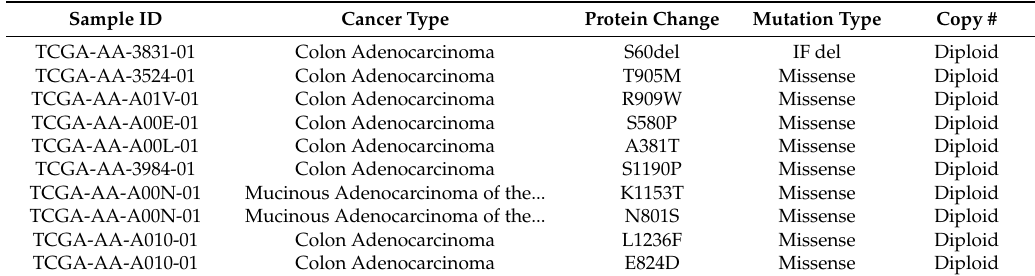
Figure 3. Modulation of the transcriptional levels of KCNMA1 in relation to TNM stage and overall survival (OS). Data regarding the levels of KCNMA1 in patients ( n = 282) with CRC were obtained from the TGCA database, through the cBioPortal for Cancer Genomics (http://www.cbioportal.org/) website. Statistical differences among groups were evaluated by applying ANOVA test. The correlation between KCNMA1 levels and OS was calculated by using the non-parametric Spearman’s test. ( a ) KCNMA1 expression levels in CRC samples at different disease stages; ( b ) correlation between KCNMA1 expression and OS in samples of CRC at stage I; ( c ) correlation between KCNMA1 expression and OS in samples of CRC at stage II; ( d ) correlation between KCNMA1 expression and OS in samples of CRC at stage III; ( e ) correlation between KCNMA1 expression and OS in samples of CRC at stage IV; Table 1. Mutations of KCNMA1 in colorectal cancer patients.